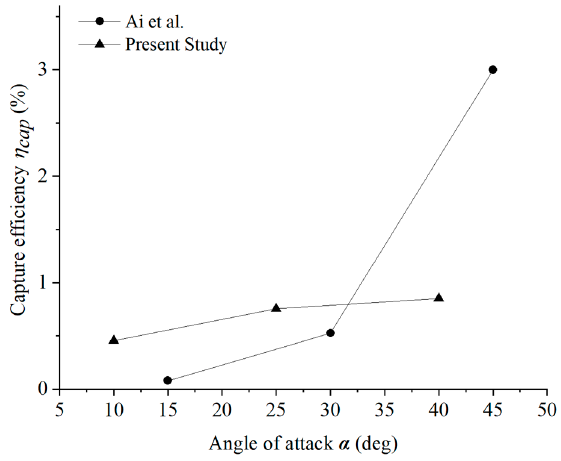
Figure 25. Comparison of the capture efficiency between Ai et al. [12] and present study.